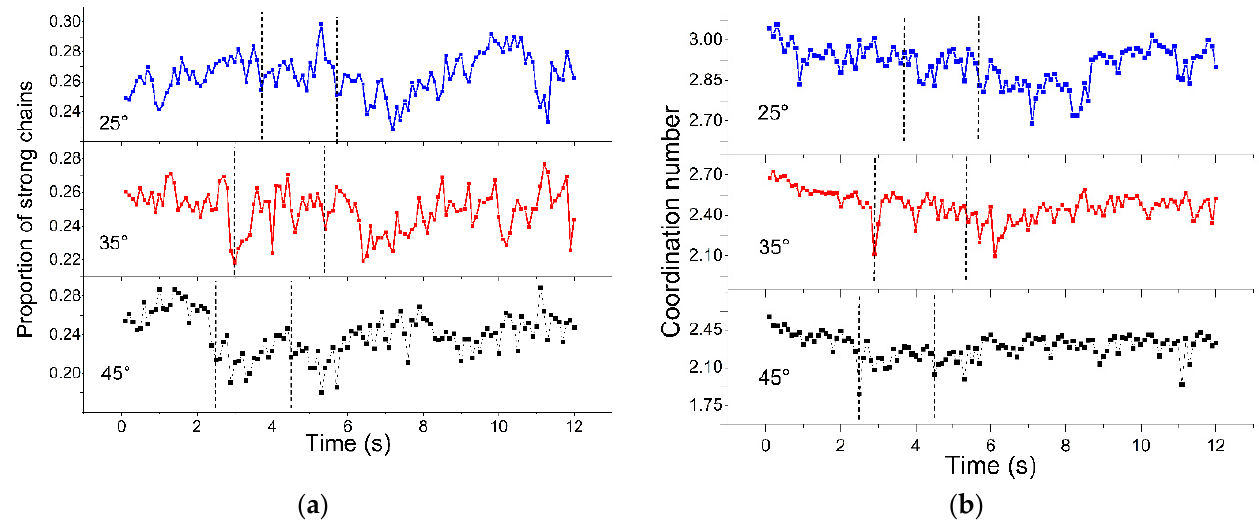
Figure 14. Characteristic evolution curve of contact force chain: ( a ) the proportion of strong chains at different internal friction angles; ( b ) the coordination number proportion at different internal friction angles.